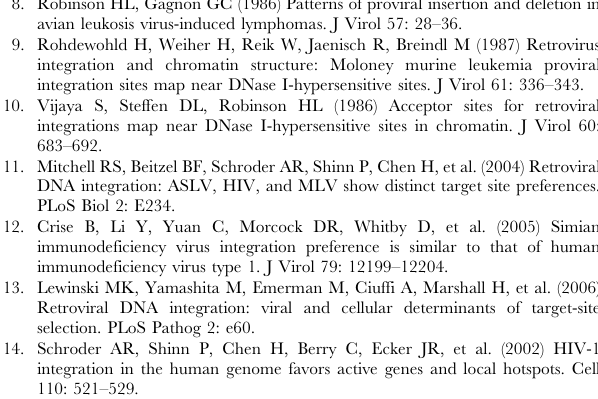
Figure S1 Vertical y stack series of nuclear HIV-IN-EGFP PICs. Vertical y stack of a HeLa cell nucleus infected with IN-EGFP virions (green) and immunostained with lamin A/C antibody (blue). A distance of 0.3 m m separates adjacent frames. White arrows indicate a single viral PIC identified as intranuclear and visible in two subsequent sections. Bars, 5 m